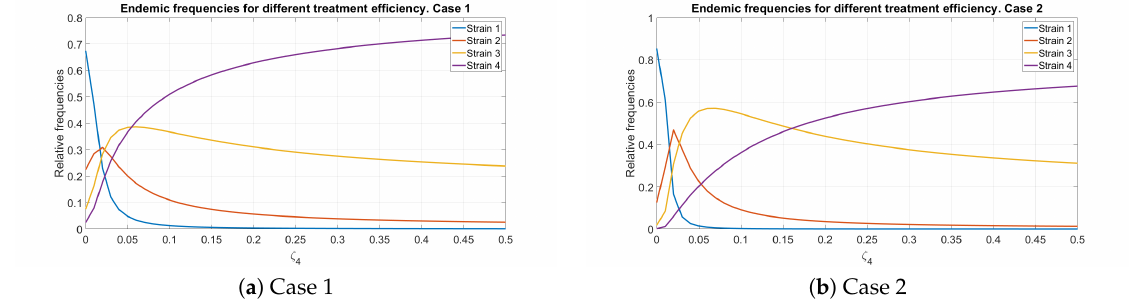
Figure 4. The relative endemic distribution of infected individuals for different values of ζ 4 . Subfigures ( a ) and ( b ) correspond to different values of mutation probabilities π i .